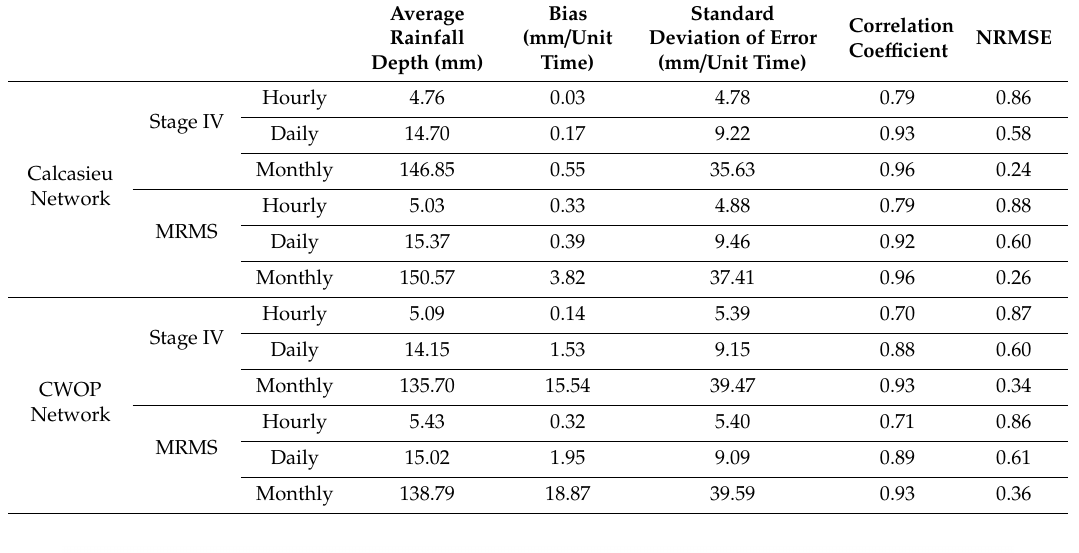
Table 1. Basic statistical skill scores for both radar-rainfall products over the entire study period (January 2017 through August 2018).